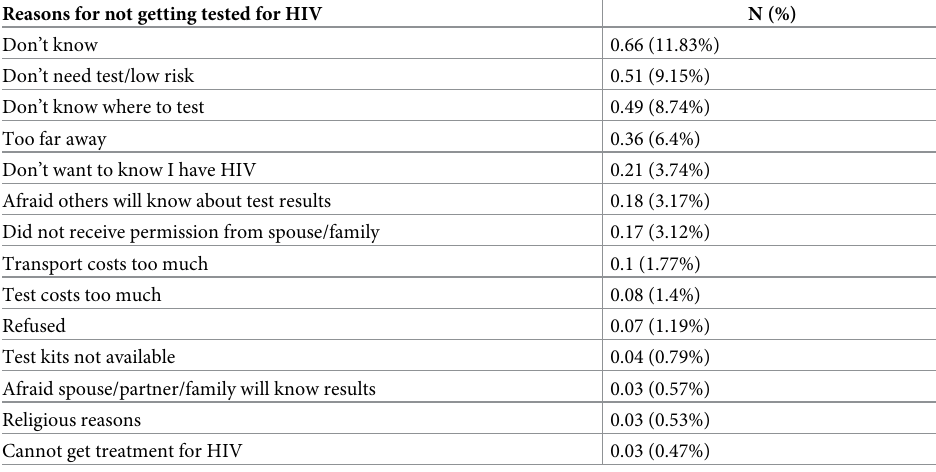
Table 4. Reasons for not getting tested for HIV among adolescents and young adults 15–24 years of age in Tanza- nia (n = 4454, N = 5.2M, all numbers below in millions). Reasons for not getting tested for